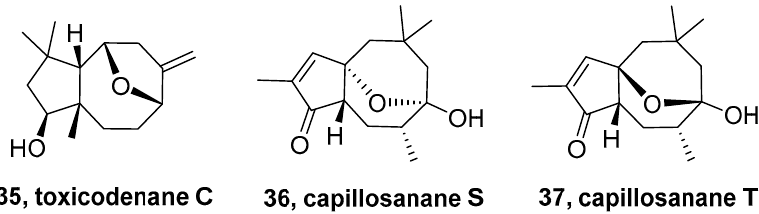
Figure 5. Structures of toxicodenane-sesquiterpenoids and capillosane-sesquiterpenoids.